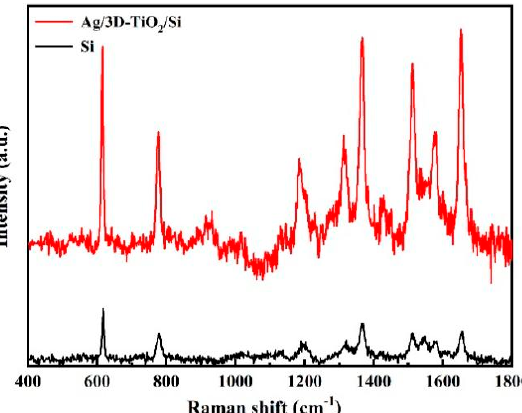
Figure 5. Raman spectra of 10 − 2 mol/L R6G solution on the Si wafer and 10 − 8 mol/L R6G solution on the Ag/3D-TiO 2 /Si substrate.